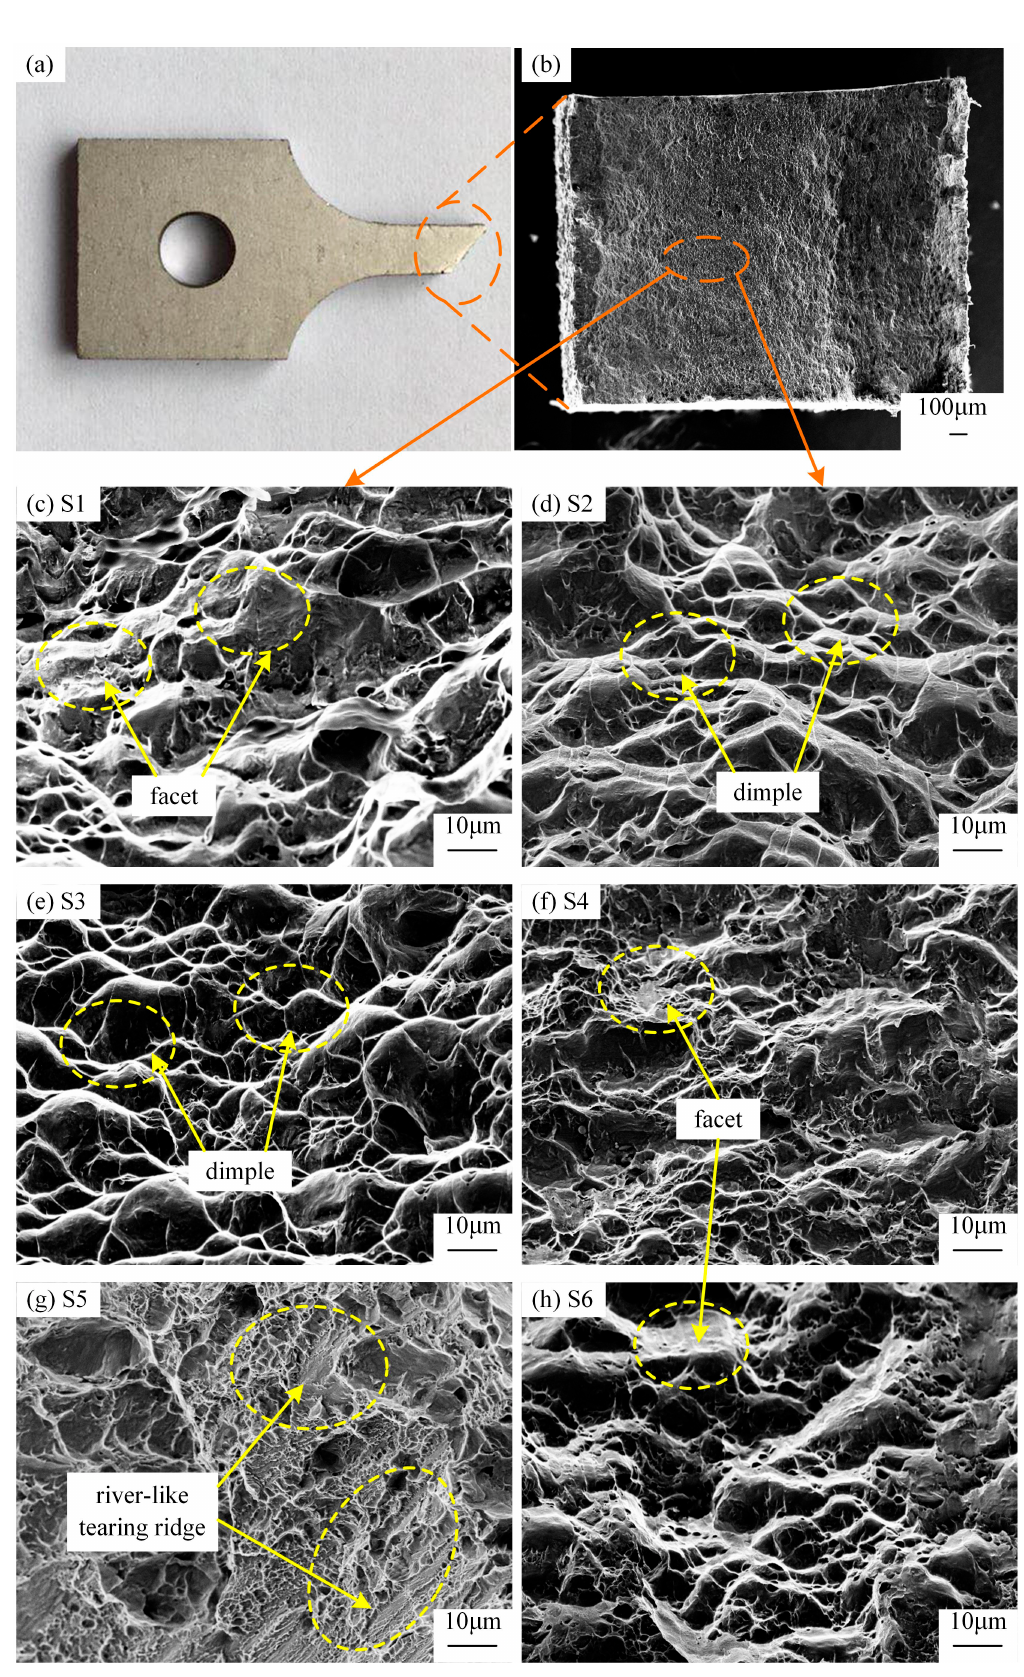
Figure 5. The tensile fracture surface morphology under different annealing processes. ( a ) The fracture sample; ( b ) Fracture profile; ( c ) S1; ( d ) S2; ( e ) S3; ( f ) S4; ( g ) S5; and ( h ) S6.